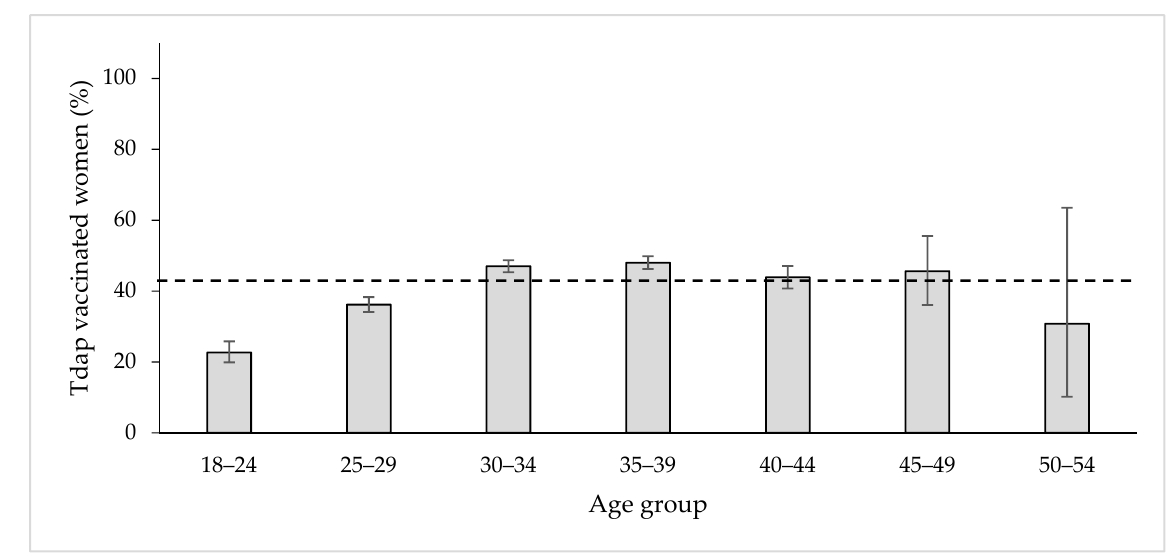
Figure 1. The percentage distribution of Tdap vaccinated women in 2019 according to the age group. The dashed line indicates the average percentage adhesion: 43.0%.